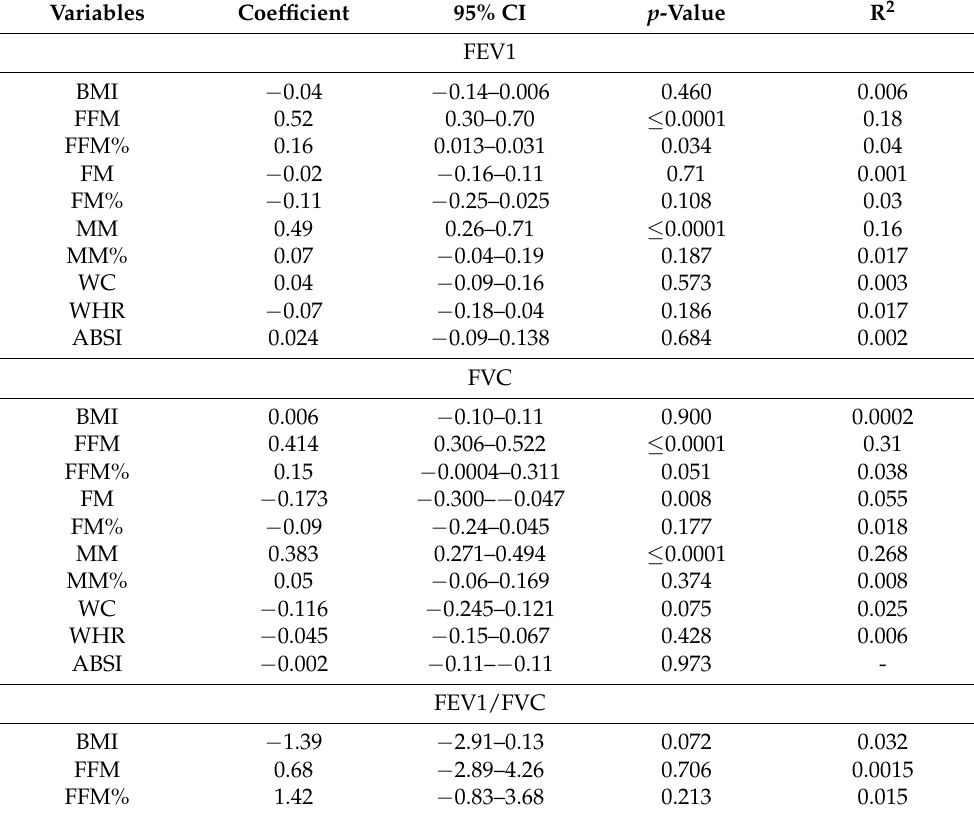
Table 3. Univariable regression analysis of FEV1, FVC, and FEV1/FVC in female athletes.